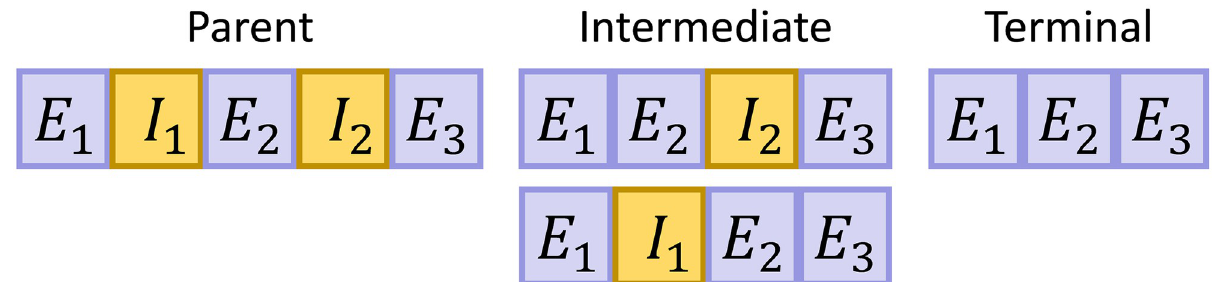
Fig 4. A two-intron mRNA species may not have well-defined “unspliced” and “spliced” forms.